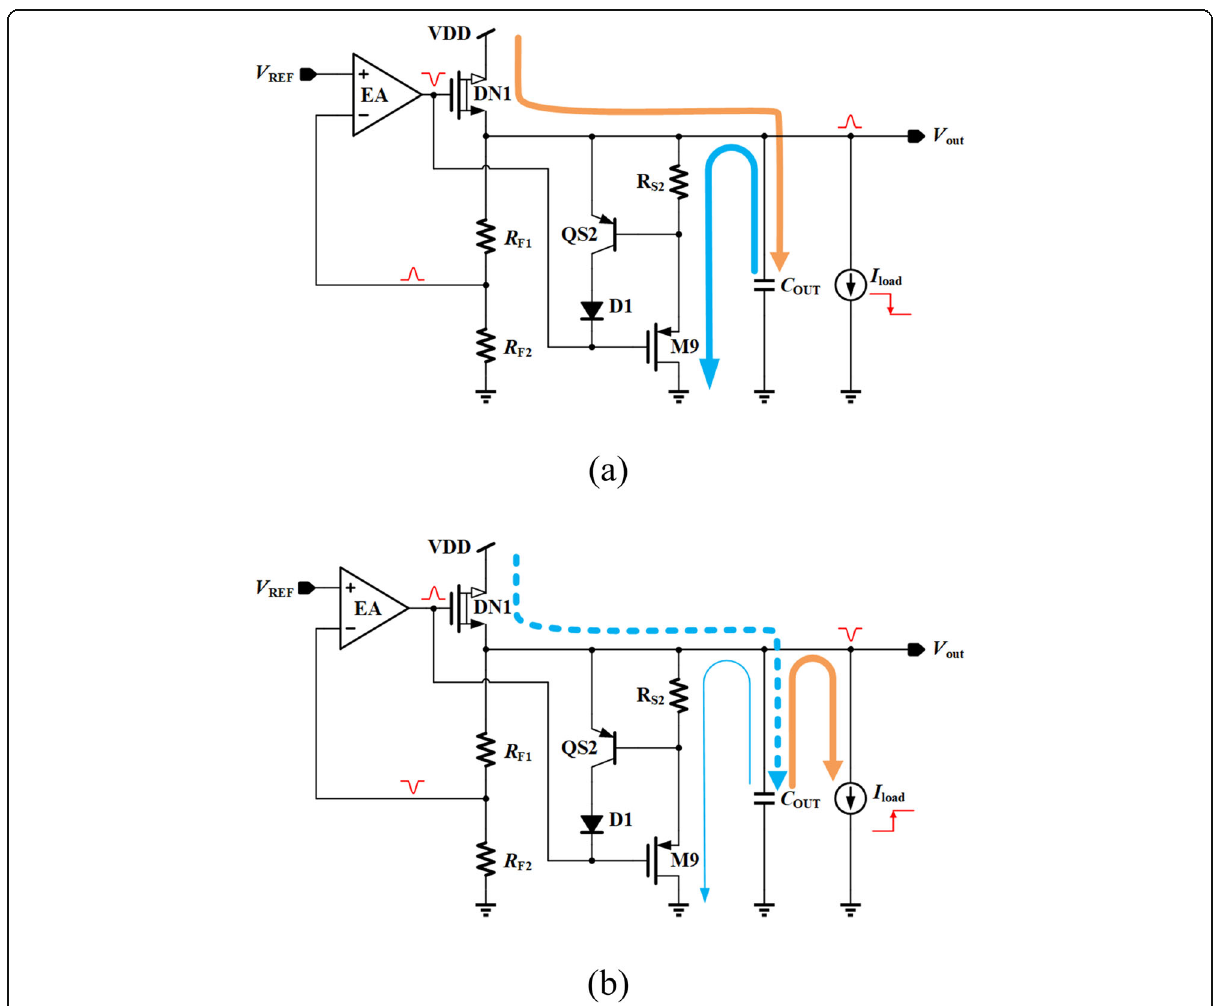
Fig. 4 Transient response of proposed VR. a heavy-to-light load current change. b light-to-heavy load current